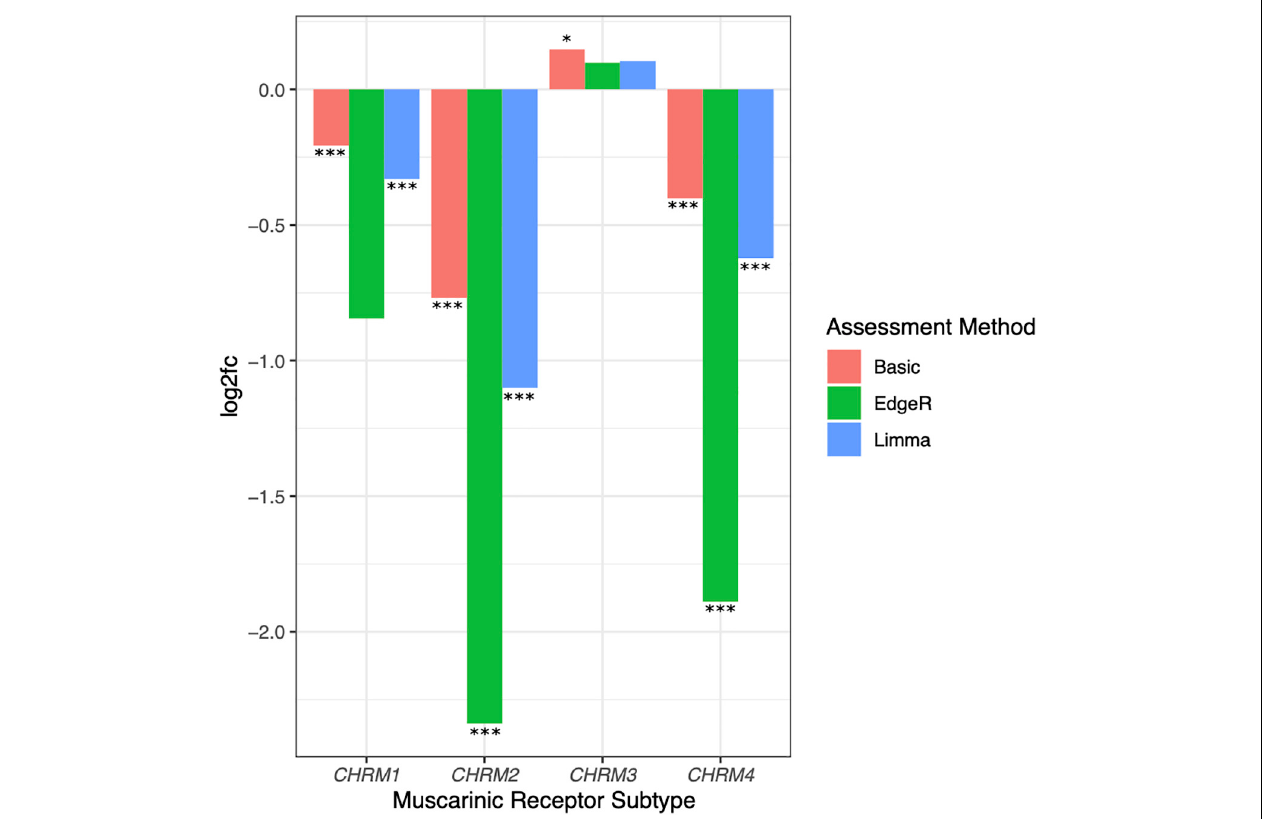
FIGURE 6 | Downregulated expression of CHRM1 , CHRM2 , and CHRM4 and upregulated expression of CHRM3 mRNA levels in colon cancer. Log2fc was assessed for CHRM1–4 levels in adenocarcinoma compared to normal colon tissues using basic fold change, limma-voom, and edgeR normalization. Changes in CHRM2 and CHRM4 expression were statistically significant (adjusted p ≤ 0.05) across all three assessment methods, while changes in CHRM1 were significant when assessed by basic fold change and limma models; changes in CHRM3 were only significant using basic log2fc. *** p ≤ 0.001, * p ≤